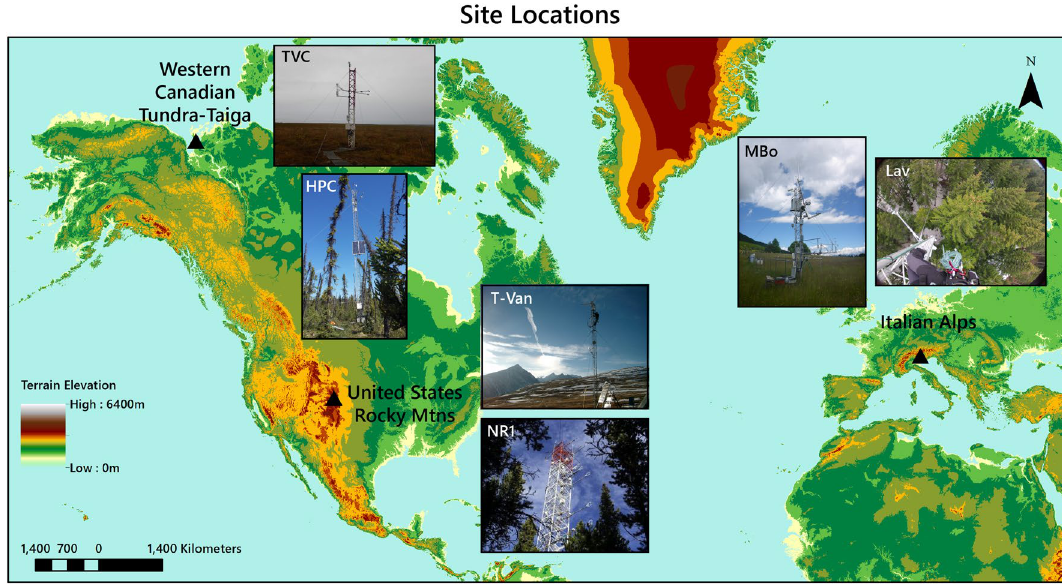
Figure 2. Site locations for the three pairs of sites (Table 1) above and below Arctic and alpine treelines. The background topographic map is generated from NASA space-based elevation data (https://visibleearth.nasa. gov/images/73934/topography#). Fluxtower site images were obtained from the following: TVC & HPC— Oliver Sonnentag (https://atmosbios.com/); T-Van—photo of the Saddle site about 350m along the ridge from T-Van taken by Andy Watt (https://archive.eol.ucar.edu/homes/stephens/RACCOON/NWRsite.html); NR1— Sean Burns, 10/07/2014, (https://ameriflux.lbl.gov/sites/siteinfo/US-NR1); MBo & Lav—Roberto Zampedri, Fondazione Edmund